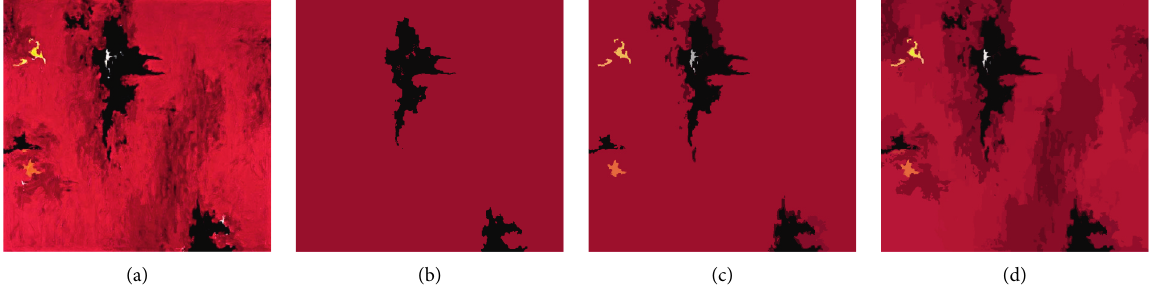
Figure 2: Clyfford Still: 1947-R-No. 1 (1947). From left to right: original image, 3, 13, and 60.